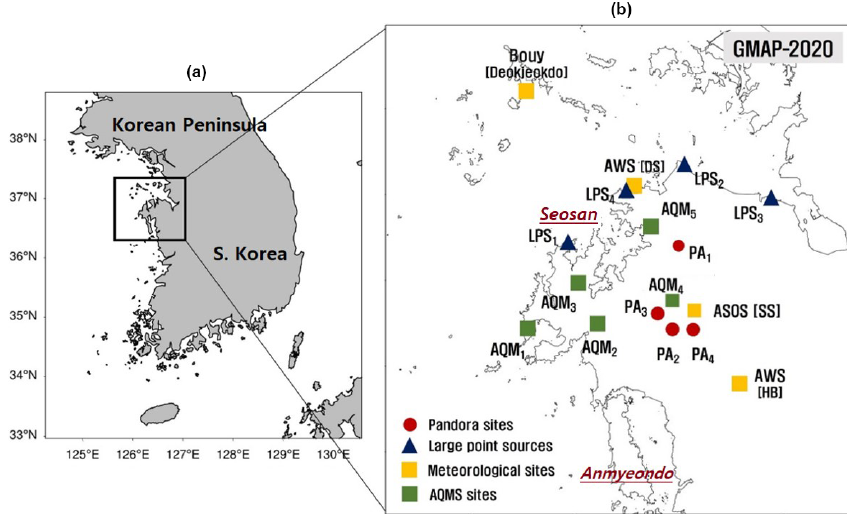
Figure 1. Map of sites used for Geostationary Environment Monitoring Spectrometer (GEMS) Map of Air Pollution (GMAP) campaigns conducted in (a) Seosan, South Korea in November 2020 to January 2021 (GMAP-2020), and (b) the Seoul metropolitan area from Octo- ber 2021 to November 2021 (GMAP-2021). (a) Measurement sites around Seosan, the study area for the GMAP-2020 campaign. Red circles indicate Pandora column measurement sites including (b) Seosan Daehoji (PA 1 ), Seosan Dongmun (PA 2 ), Seosan city council (PA 3 ), and Seosan super site (PA 4 ). Blue triangles indicate large point sources (LPSs) including the Taean and Dangjin thermal power stations (LPS 1 and LPS 2 , respectively), Hyundai steelworks (LPS 3 ), and Daesan petrochemical complex (LPS 4 ). Yellow squares indicate Automated Syn- optic Observing System meteorological sites in Seosan (Met 1 ), AWS (Met 2 ), and buoy (Met 3 ). Green squares indicate air quality moni- toring (AQM) network stations including Padori (AQM 1 ), Leewon (AQM 2 ), Taean (AQM 3 ), Daesan (AQM 4 ), Seongyeon (AQM 5 ), and Dongmoon (AQM 6 ). In the right panel, the black line indicates the route used for car-based differential optical absorption spectroscopy (Car- DOAS) measurements and the blue dotted line indicates the horizontal domain of Geostationary Coastal and Air Pollution Events (GEO- CAPE) airborne simulator (GCAS) measurements taken during the GMAP-2021